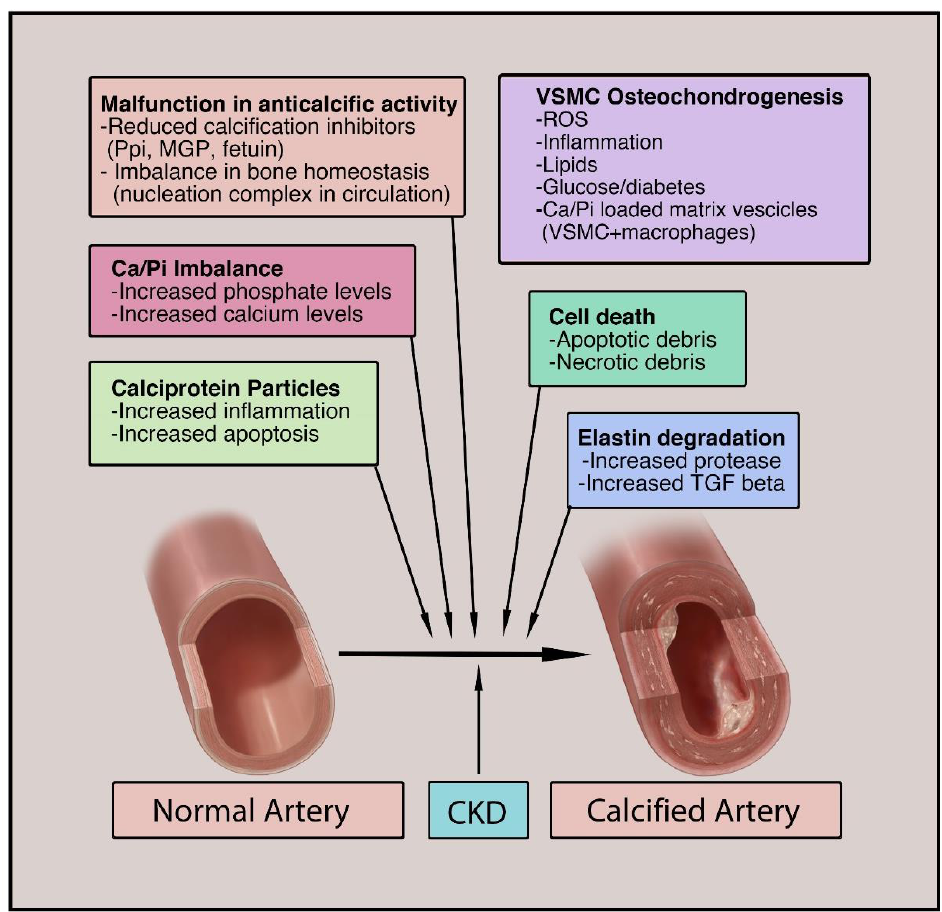
Figure 3. Major mechanisms involved in vascular calcification: Vascular calcification is an active process with multifacto- rial origins. Significant contributors to this include failure in the anti-calcification process, imbalance in bone homeostasis, osteochondrogenesis of VSMCs, calciprotein particles, cell death, elastin degradation, and extracellular vesicle formation and release. The combination of these factors in the setting of CKD leads to the development of both intimal and medial calcification. VSMC, vascular smooth muscle cell; Ca, calcium; Pi, inorganic phosphate; Ppi, inorganic pyrophosphate; MGP, matrix Gla protein; TGF, transforming growth factor; ROS, reactive oxygen